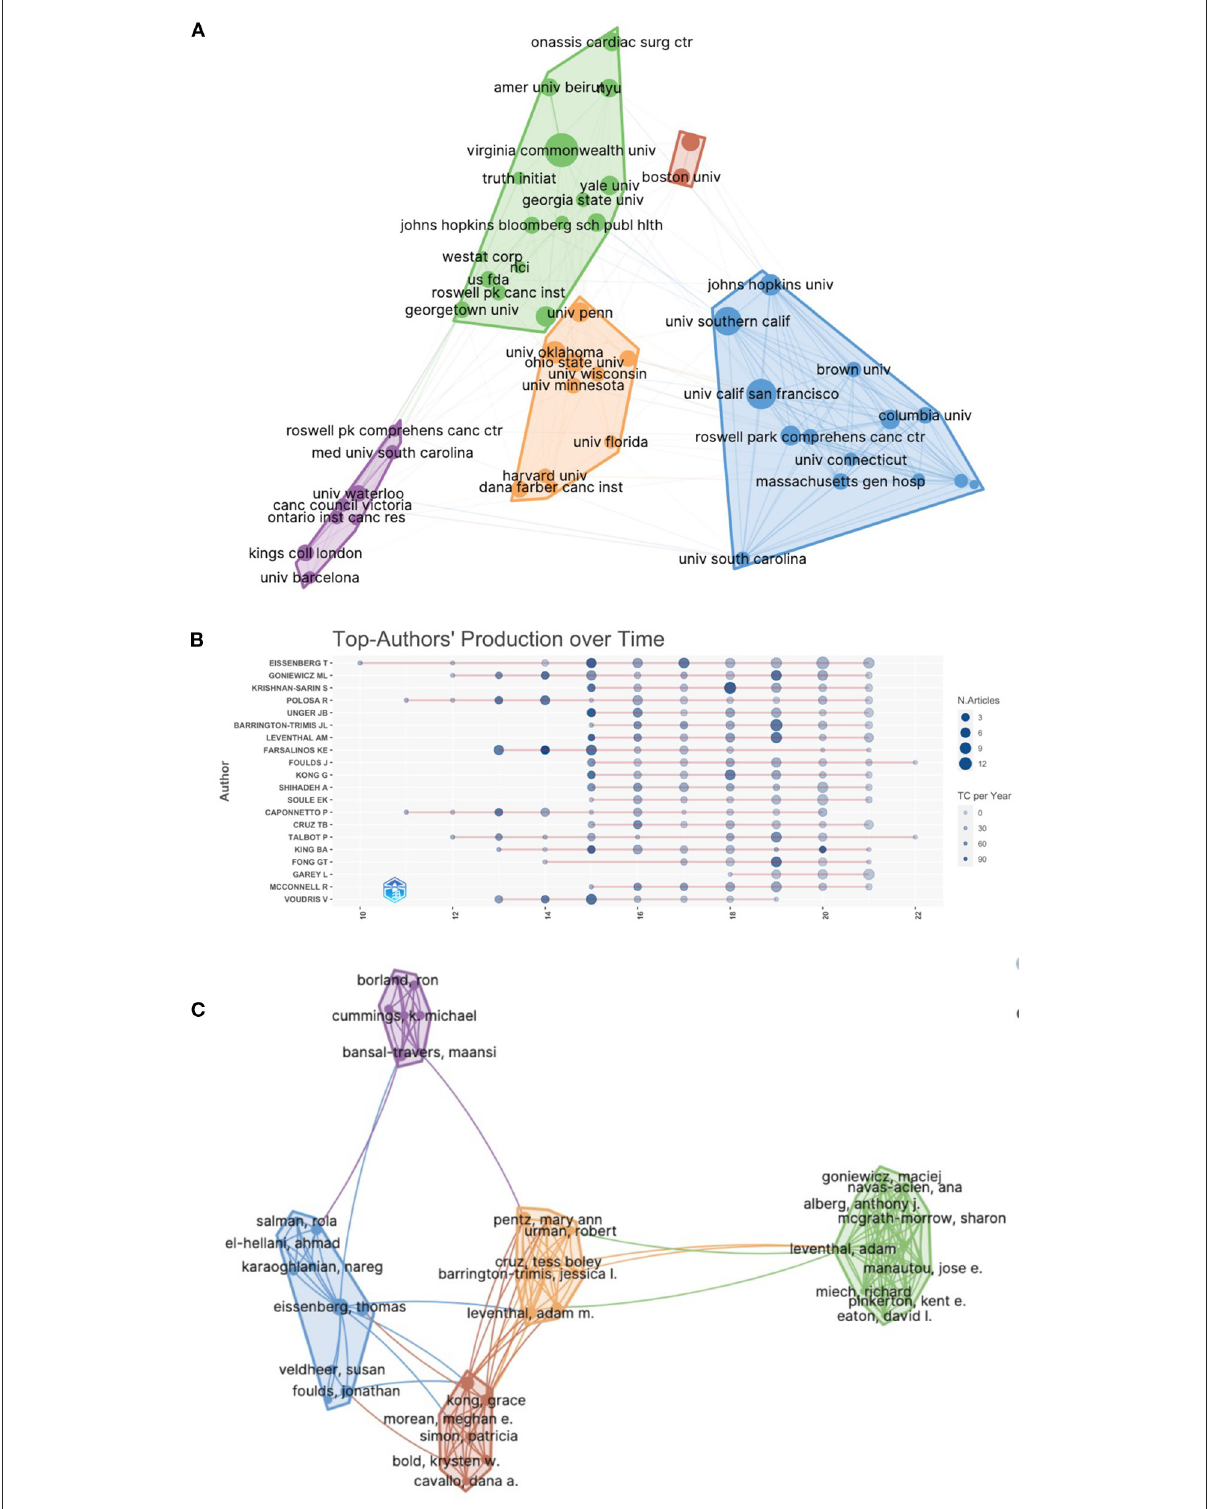
FIGURE3 Visual analysis graphs between active institutions and authors. (A) cluster analysis between posting institutions; (B) timeline analysis of the top 10 posting volume authors; (C) cluster analysis of collaboration between authors.